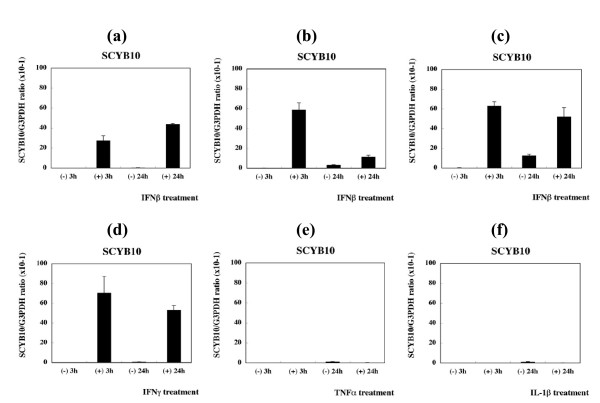
Real-time RT-PCR analysis of SCYB10 expression in PBMC. See the footnote of Figure 1. The panels represent the expression of SCYB10 in (a) #1, IFNβ; (b) #2, IFNβ; (c) #3, IFNβ; (d) #1, IFNγ; (e) #1, TNFα; and (f) #1, IL-1β.